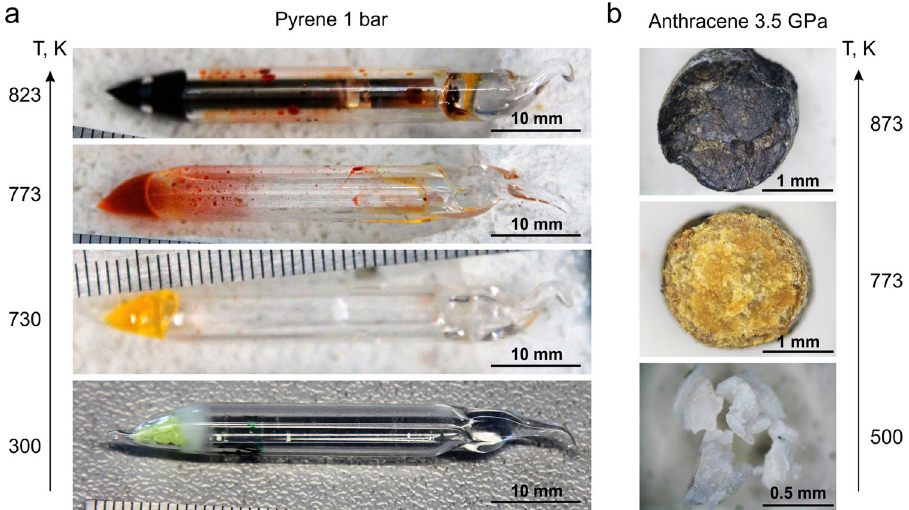
Figure 2. Images of the quenched samples after recovery. ( a ) – change in color of the pyrene reaction products at 1 bar and 300 (bottom image), 730, 773 and 823 (top image) K. ( b ) – change in color of the anthracene reaction products at 3.5 GPa and 500 (bottom image), 773 and 873 (top image) K.